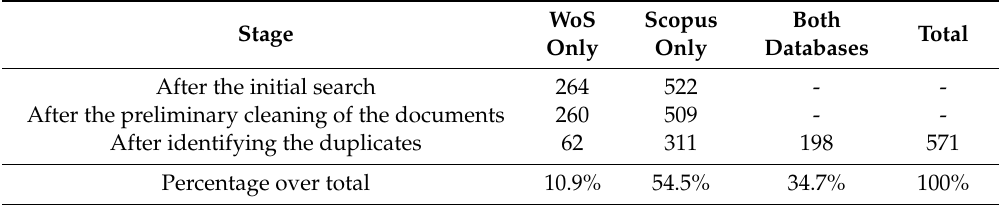
Table 4. Amount of records retrieved at the databases Web of Science and Scopus. WoS Scopus Both Total Stage Only Only Databases After the initial search 264 522 - - After the preliminary cleaning of the documents 260 509 - - After identifying the duplicates 62 311 198 571 Percentage over total 10.9% 54.5% 34.7%